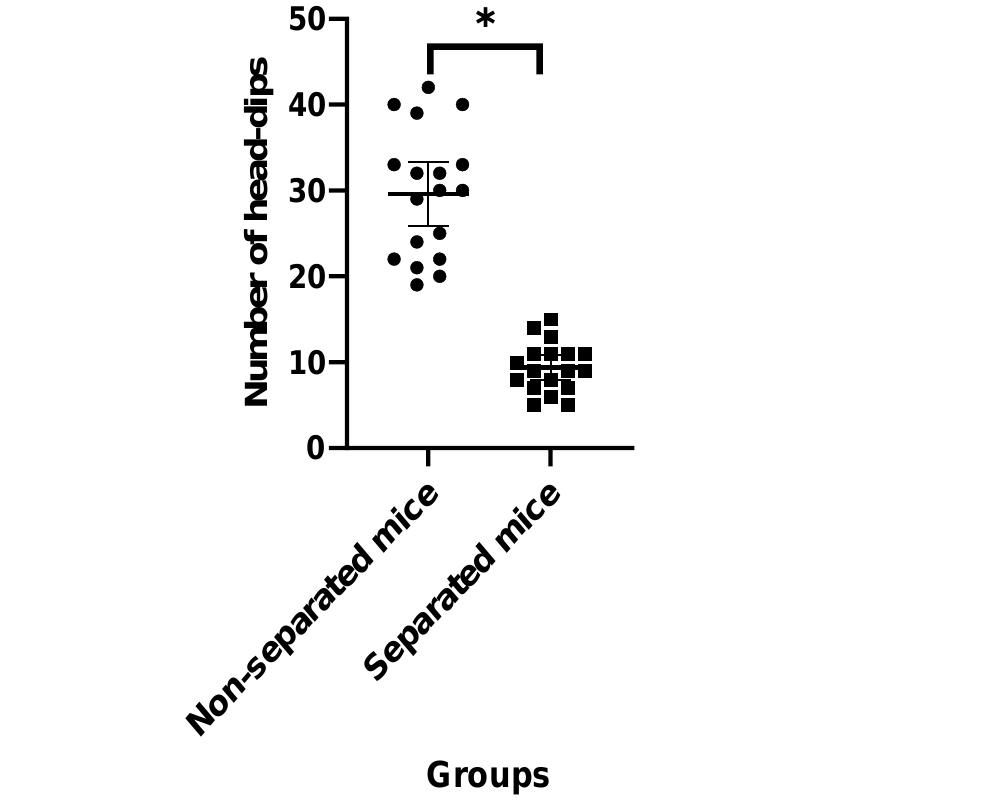
Figure 5. Number of head-dips in experimental groups. (*) indicates significant difference ( p < 0.05) between separated and non-separated mice by the unpaired t test ( n = 18/each group).